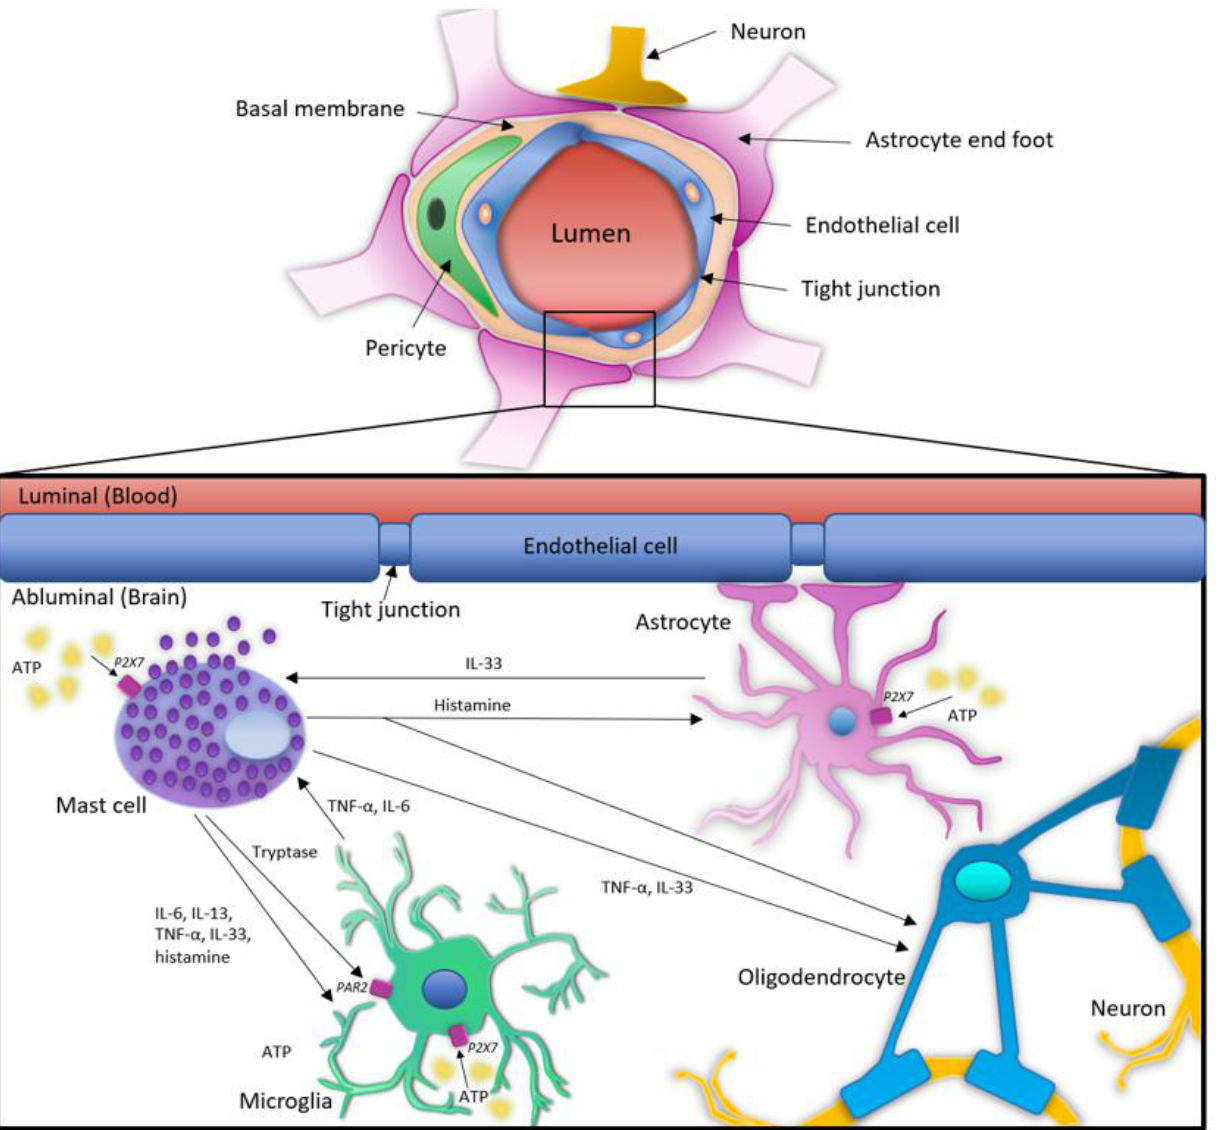
Figure 1. ATP-mediated MCs interactions with microglia, astrocytes, and oligodendrocytes. The blood brain barrier consists of a semi-permeable border composed of endothelial cells and tight junctions wrapped around a blood vessel. At the abluminal side of the blood brain barrier a variety of cell types can be found, such as resident glial cells or wandering immune cells. One of the immune cells found on the abluminal side are MCs that possess an ability to influence the function of microglia, astrocytes, and oligodendrocytes, through activation of P2XRs, resulting in a release of various mediators, such as of histamine, tryptase, IL-6, IL-13, TNF- α and IL-33. On the other hand, microglia can release TNF- α , IL-6 and potentially IL-33 upon P2XR activation, which will result in altered function of mast cells and a stronger immune response.